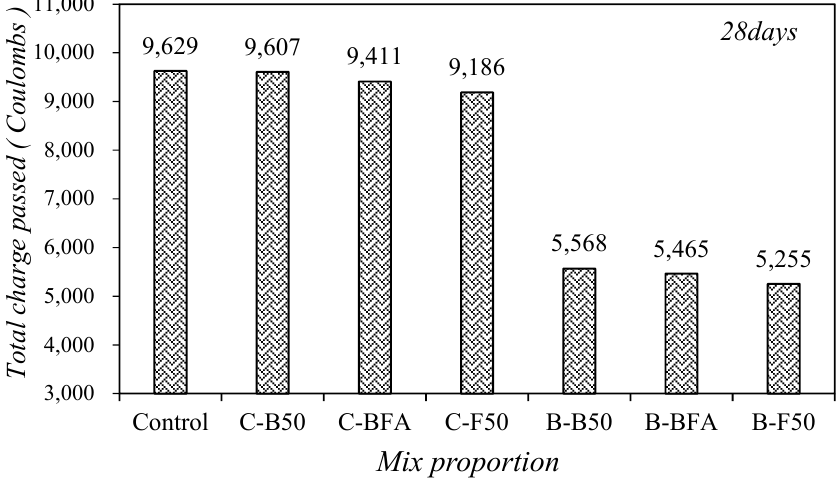
Figure 8 . Changes in chloride ion penetrability of mortar with mixed fine aggregates Figure 8. Changes in chloride ion penetrability of mortar with mixed fine